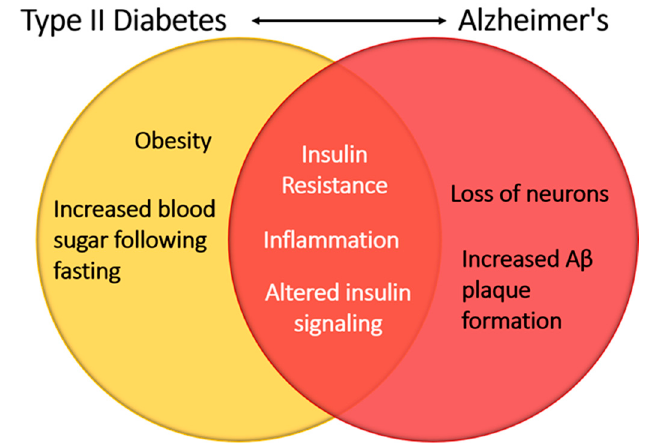
Figure 7. Insulin signaling linking Type II diabetes and Alzheimer’s disease. Alterations in glucose homeostasis have led to modification of insulin receptor signaling. Within the central nervous system, insulin receptor signaling perturbations result in the hallmarks of neurodegenerative diseases such as increased β -amyloid plaque formation and a loss of neurons.